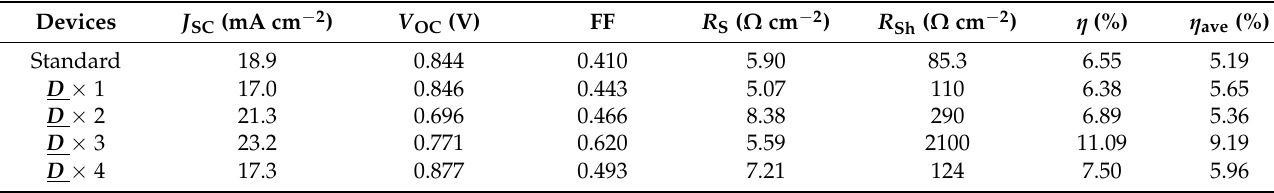
Table 1. Measured photovoltaic parameters of solar cells.